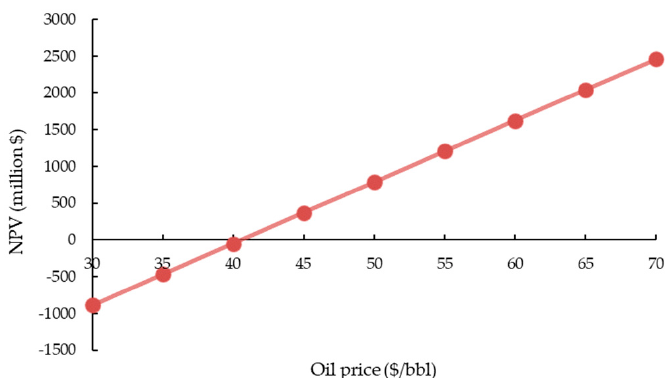
Figure 5. NPV under different oil prices (without considering uncertainty).